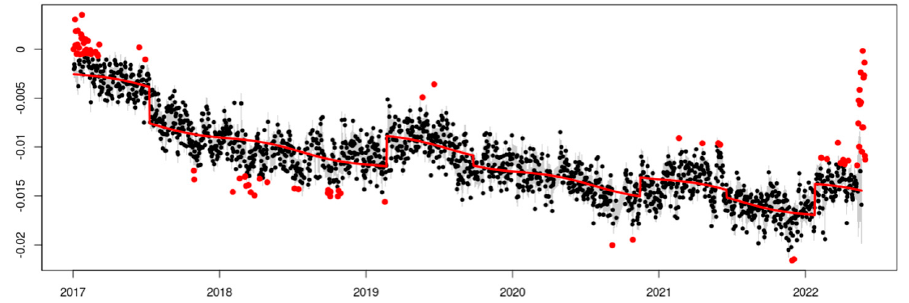
Figure 8. Final adjustment with seasonality in the time series of the EPEC station. The time series fitted is with sinusoidal